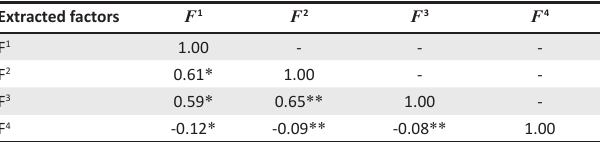
TABLE 7: Pearson correlations between extracted factors ( n = 1749).